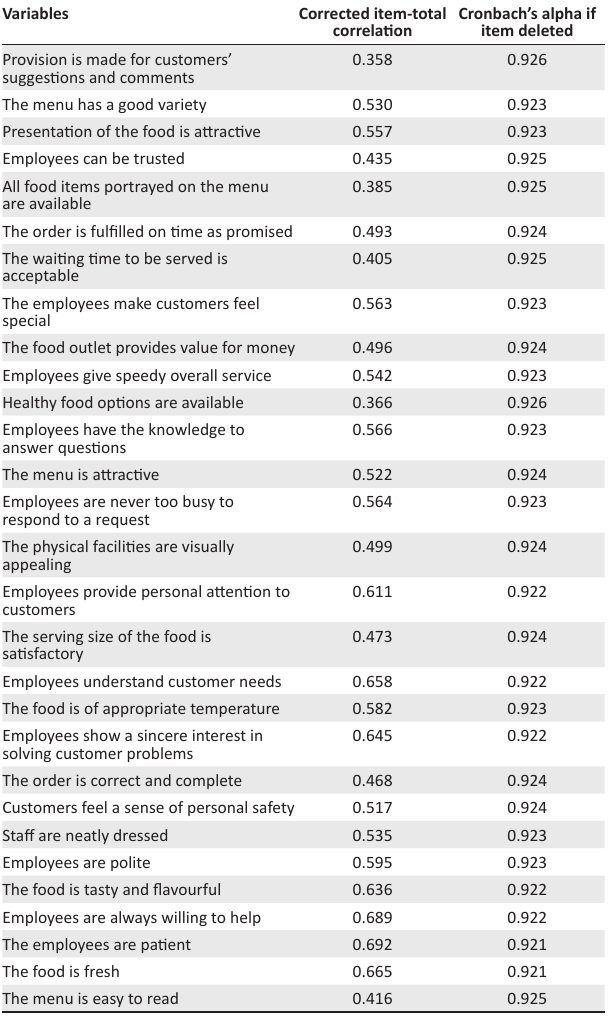
TABLE 1: Item-total statistics for the SERVQUAL/DINESERV scale. Variables